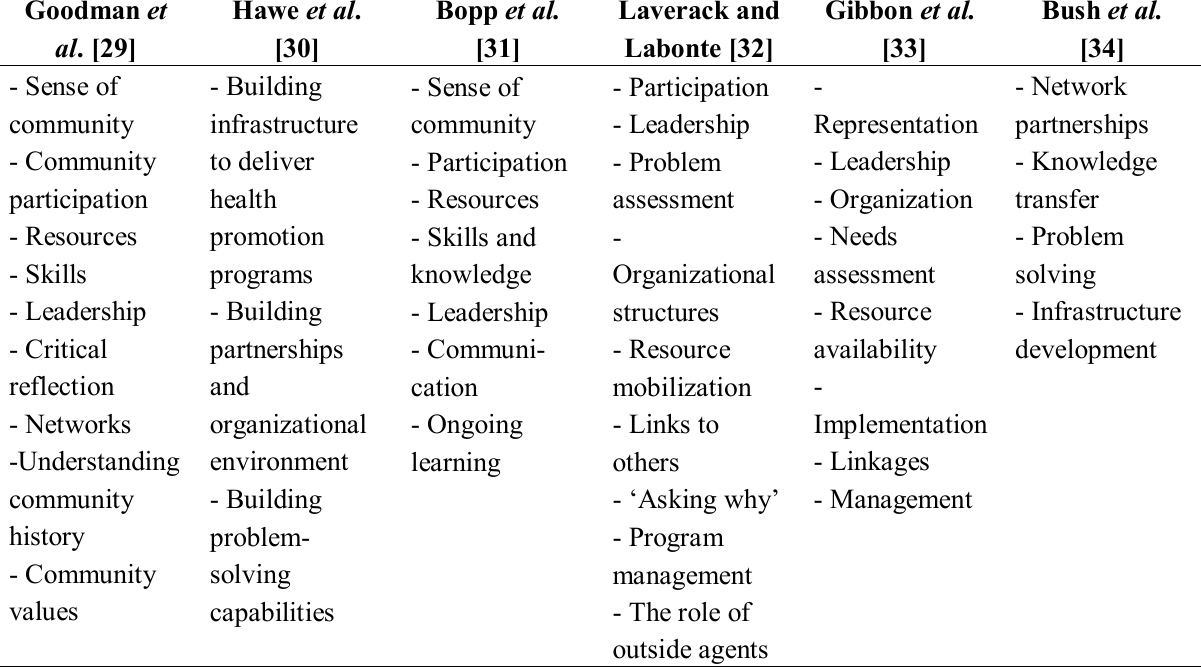
Table 2. Organizational domains of community empowerment elaborated by selected authors (Smith et al. , [25]